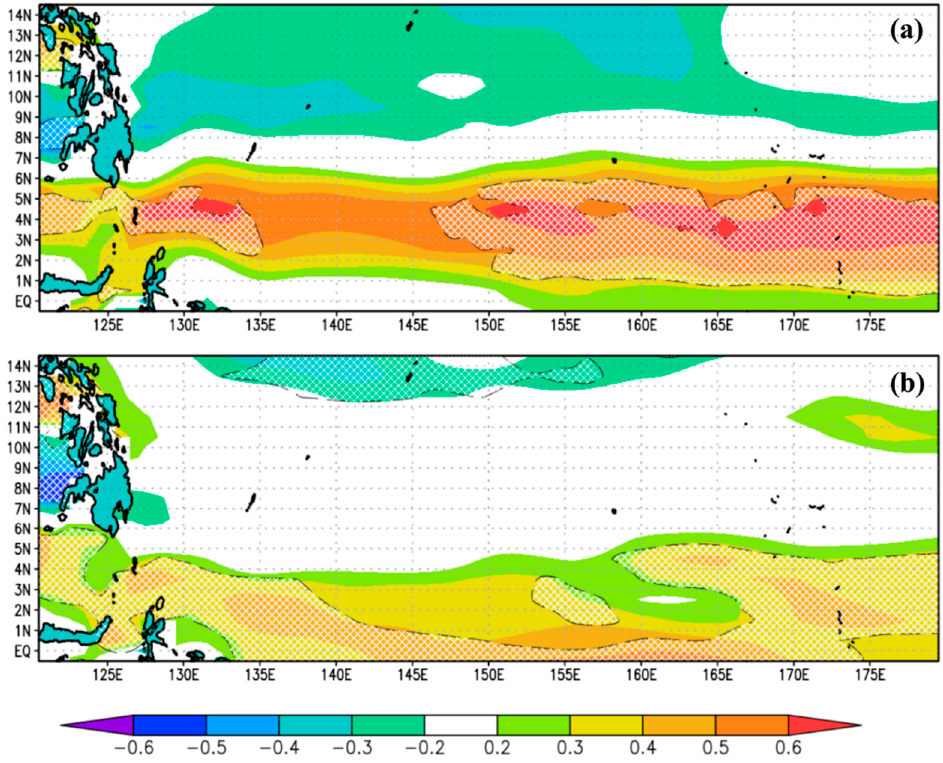
Figure 10. Correlation map of intensity westerly wind with the zonal current during EP EN ( a ) and CP EN ( b ). Level of confidence of 90% is represented by shaded white tiles, and a color bar is displayed along the bottom side.